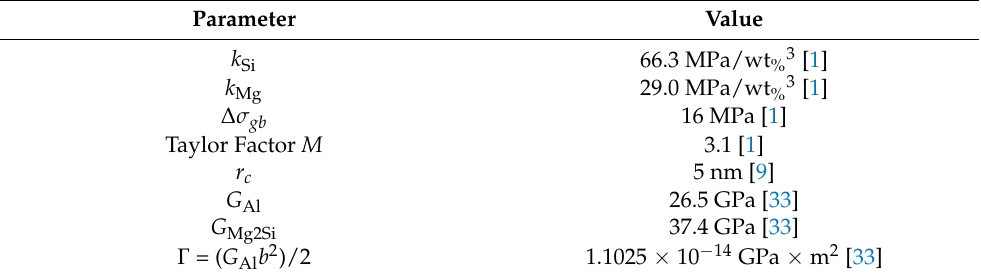
Table 5. Input parameters for yield strength and hardness